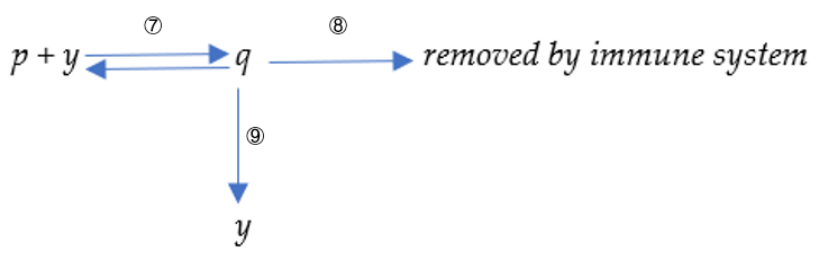
Figure 2. The role of environmental antigens in immune response.